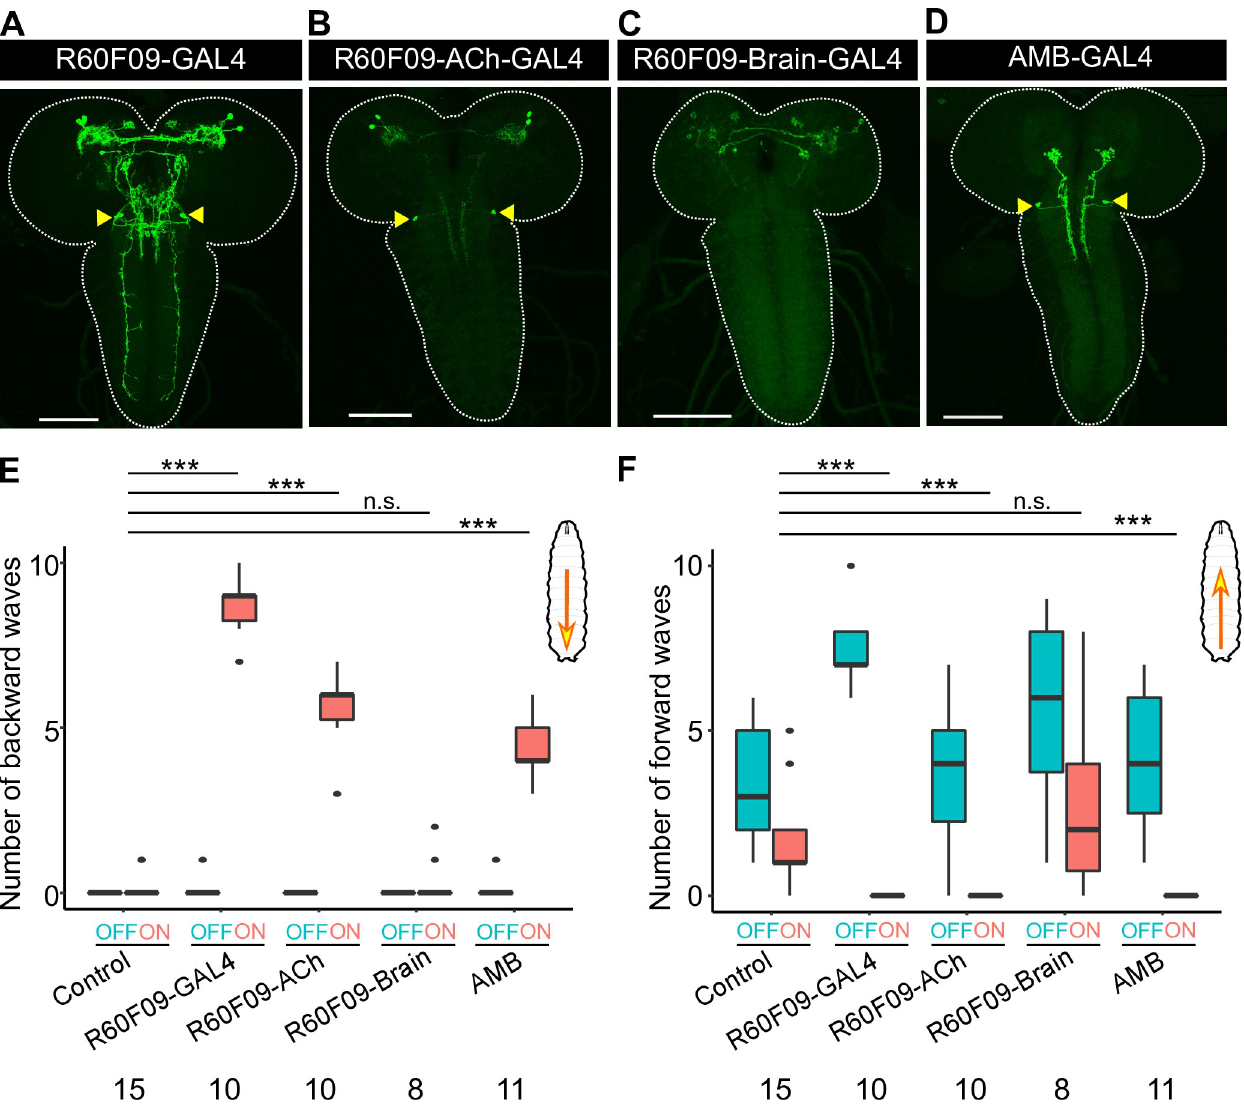
Fig 1. AMBs are a pair of neurons in SEZ that can induce backward locomotion upon activation. (A-D) Expression patterns of GAL4 lines. The yellow arrowheads indicate the somas of AMBs. Scale bar, 100 μ m. Genotypes of each GAL line are shown in S1 Table. (E, F) The number of backward/forward waves in 10 seconds before (OFF) or during (ON) optogenetic activation with CsChrimson. Genotypes: w ; UAS-CsChrimson /+; +/+ (Control); other four lines drive CsChrimson by GAL4 lines shown in (A-D). Control, n = 15; R60F09-GAL4 , n = 10; R60F09-ACh-GAL4 , n = 10; R60F09-Brain-GAL4 , n = 8; AMB-GAL4 , n = 19. In the boxplot, the width of the box represents the interquartile range and the dot represent outlier in the graph. The whiskers extend to the data point which is less than 1.5 times the length of the box away from the box, and the dot represent outlier. We assessed statistical significance using the Wilcoxon rank sum test and corrected for multiple comparisons using the Holm method. ��� p <